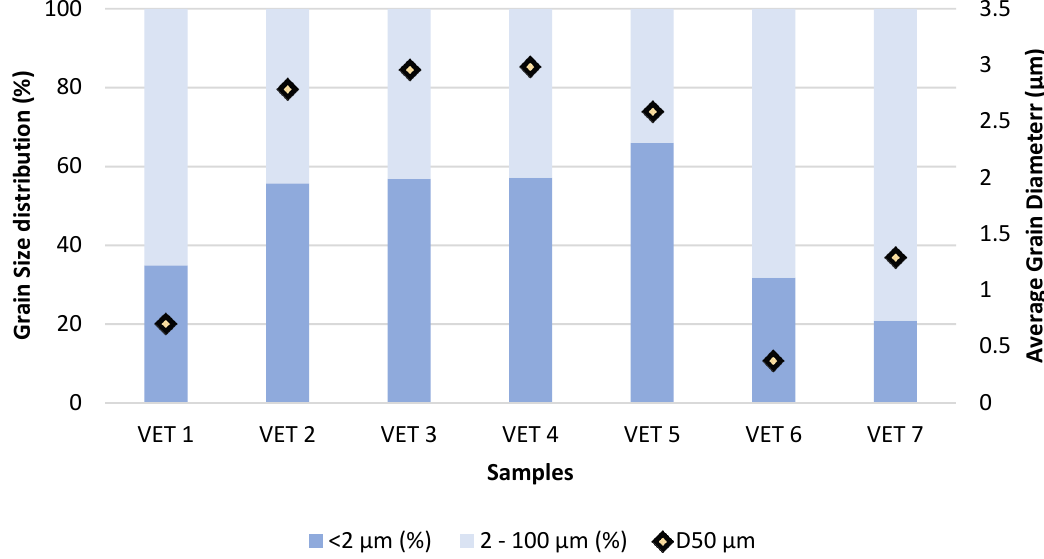
Figure 1. Grain size distribution of the Group I and Group II samples.